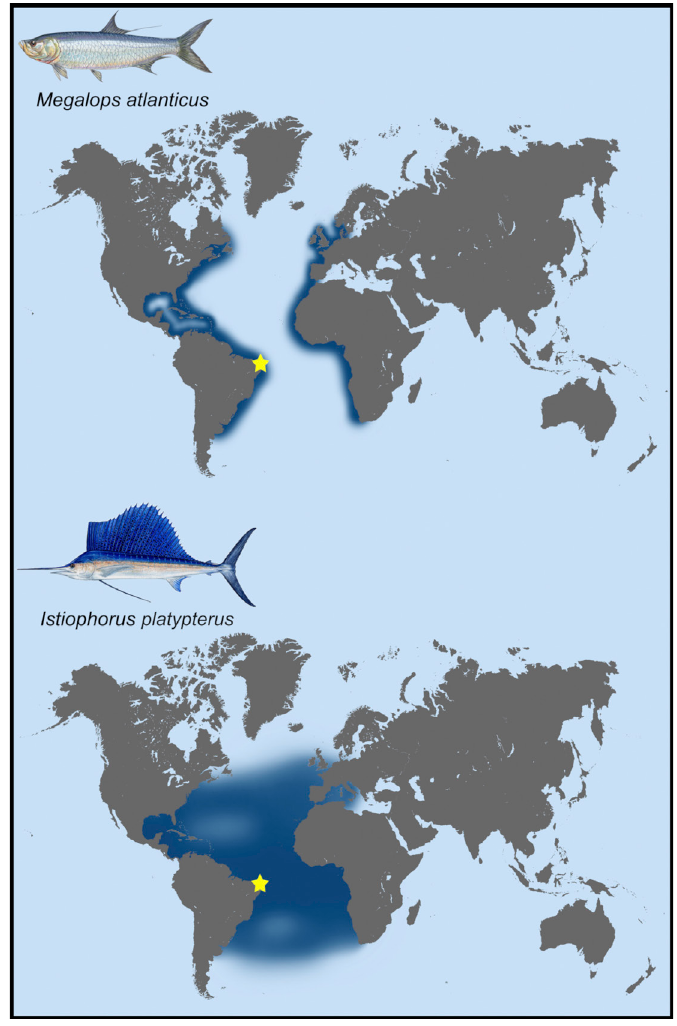
the yellow stars represent the collection sites of the